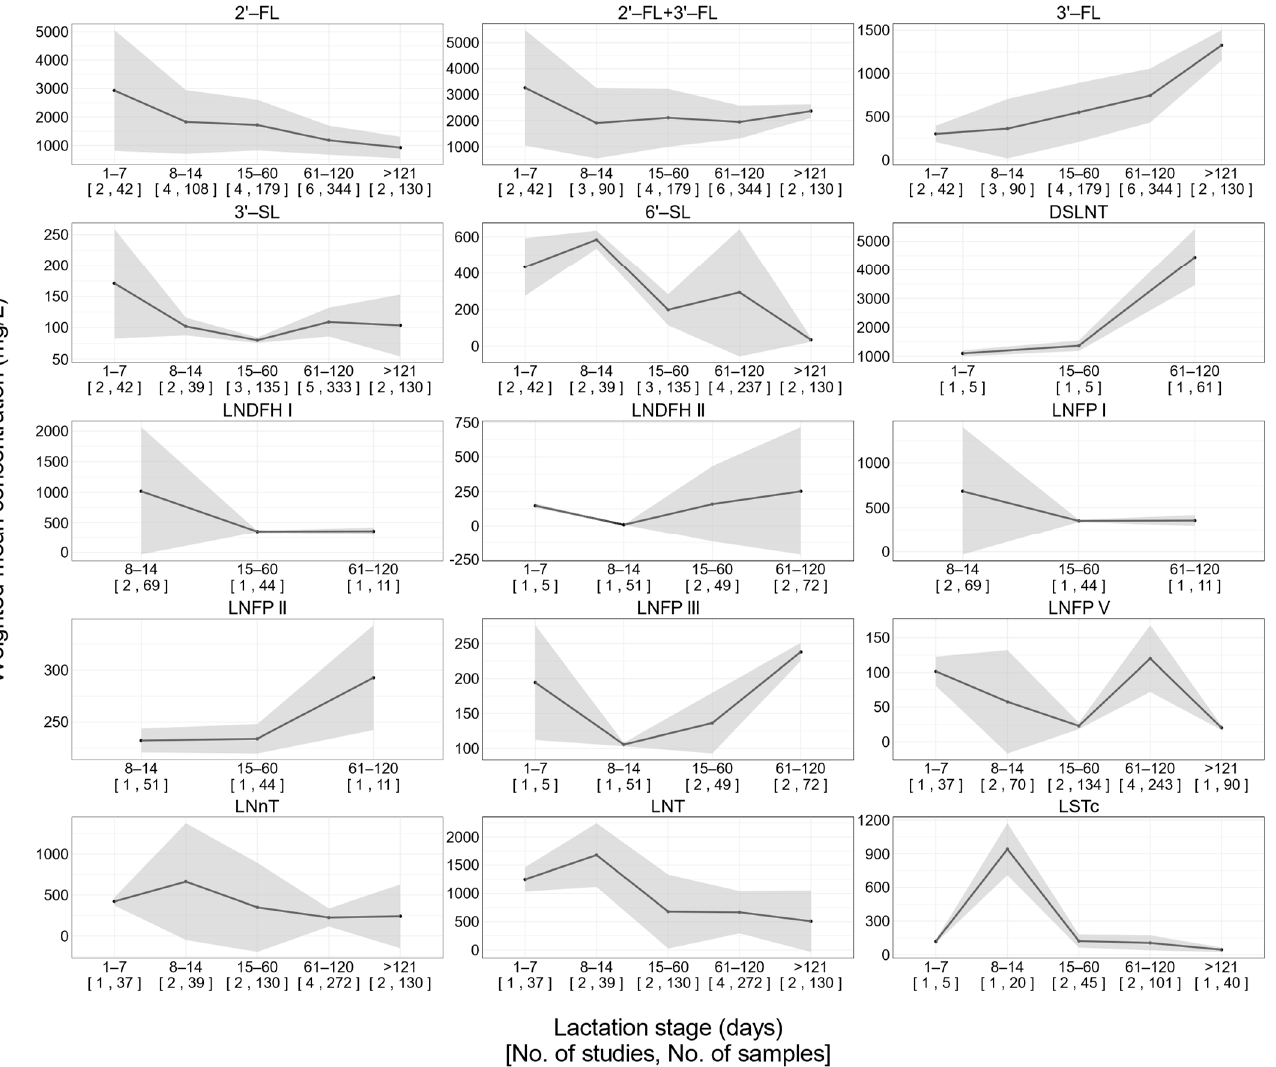
Figure 3. Longitudinal changes in individual HMOs. Table 2. Results of subgroup heterogeneity analysis.